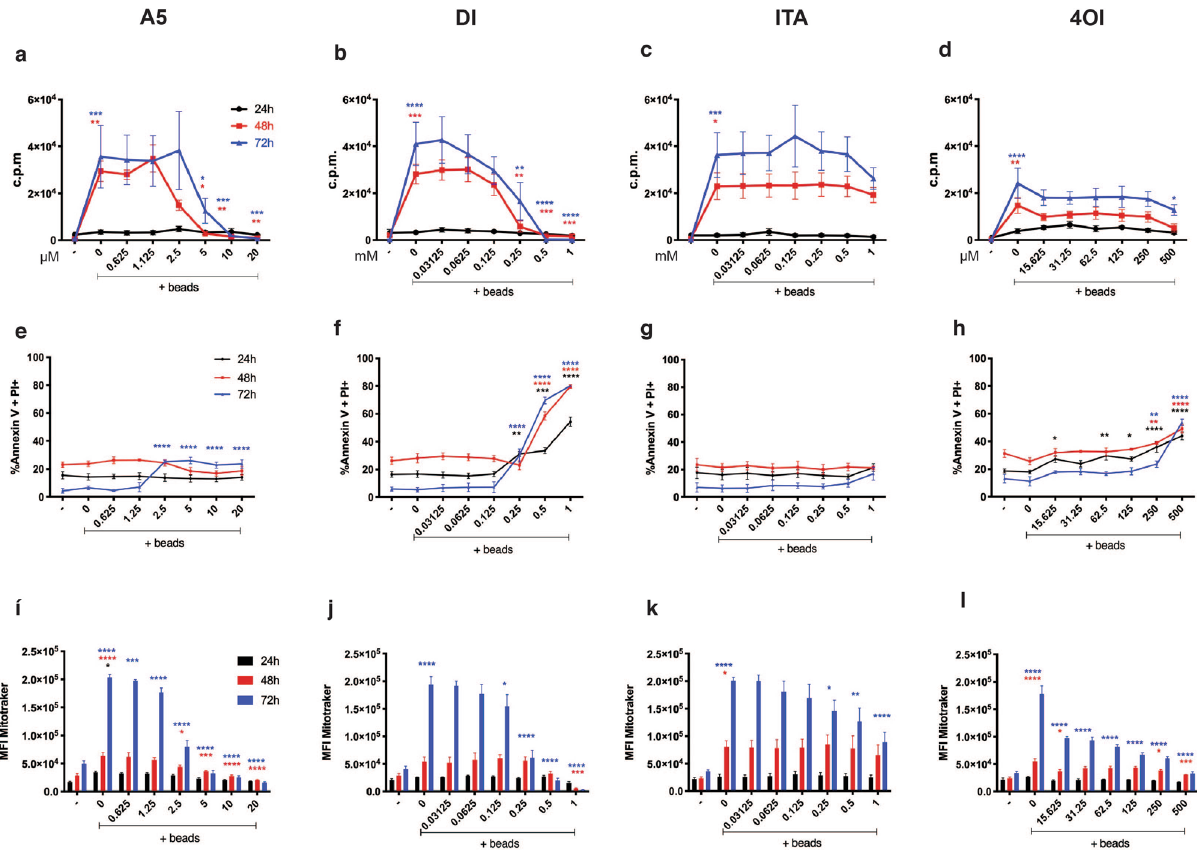
Figure 1. SDH inhibition impact proliferation, apoptosis, and mitochondrial potential. PBMCs were activated with anti CD3/CD28 beads and exposed to serially diluted atpenin A5 (A5), dimethyl-itaconate (DI), itaconic acid (ITA), or 4-octyl-itaconate (4OI). ( a – d ) Proliferation was evaluated via 3 H-thymidine incorporation assays showed as c.p.m. (counts per minutes) (n = 3, with six technical replicates) ( e – h ) Percentages of dead cells are provided as double positive for annexin V and propidium iodide staining. ( i – l ) Mean Fluorescence Intensity (MFI) is shown after mitotracker staining gated out of live cells (n = 3 independent experiments). Continuous lines or bar charts were coloured referring to different time points: 24 h black, 48 h red, 72 h blue. All charts are representative of mean and ± s.e.m. P values are calculated using two-way ANOVA test followed by Dunnet’s test to the activated untreated control. *P < 0.05, **P < 0.01, ***P < 0.001, ****P <